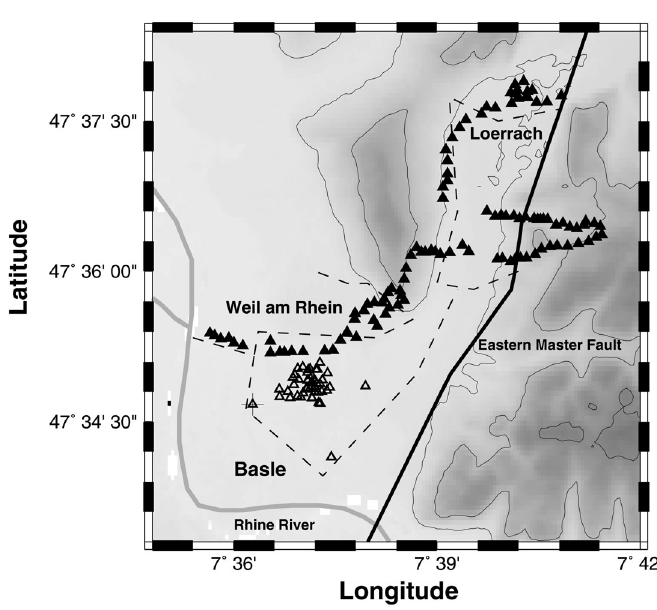
Fig. 1. Location of the single station measurements (filled triangles) and array settings (open triangles) in the study area in the Rhine Rift Valley near Basle. The dashed lines indicate the city borders and the cross shows the location of the deep drillsite in